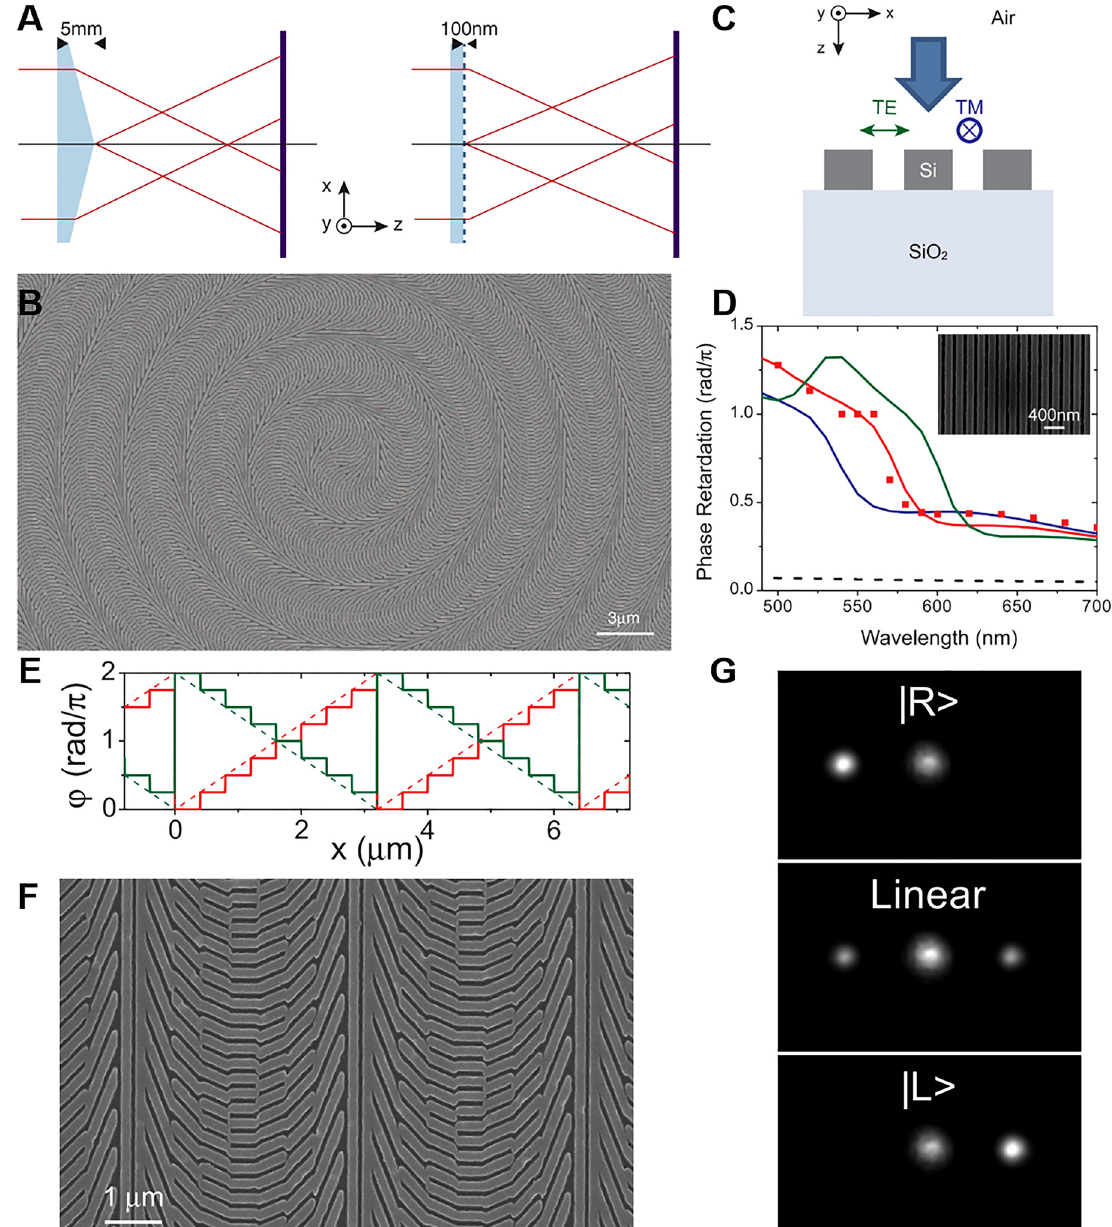
Figure 1: Three dielectric gradient metasurface optical elements (DGMOE) for the manipulation of light [49]. (A)SchematicofaconventionalglassaxicongeneratingaBesselbeam(left)andaDGMOEaxiconfeaturinganultrathinpatternedlayerofsilicon on a quartz substrate (right). (B) Scanning electron microscopy (SEM) image of the fabricatedDGMOE axicon constructedfrom Si nanoantennas. (C) Schematic view of a periodic 120-nm-wide and 100-nm-high Si nanobeam array on fabricated ultrathin wave plates. (D) Simulated phase retardation of a TM-polarized wave with respect to a TE-polarized wave for nanobeam arrays with widths of 100 nm (blue), 120 nm (red), 140 nm (green),withthesamethicknessof100nmanddutycycleof60%.Measurementsofthephaseretardation(redsquares)obtainedwithanarrayof 120-nmwidths(SEMimageininset) showgoodagreementwiththesimulations.Thephaseretardationofthewaveplatevariesfrom0 . 4 π to1 . 2 π with the wavelength from 490 to 700 nm. In contrast, the phase retardation is approximately equal to 0 . 05 π for a 100-nm-thick calcite fi lm (dashedblackline).(E)Discretized(solidline)andcontinuous(dashedline)phasepro fi leofaDGMOEgratingforilluminationwithLCPlight(red) and RCP light (green). (F) SEM image of the fabricated grating. (G) Measured diffraction patterns from the grating under illumination with right circular polarization (top), linear polarization (middle), and left circular polarization (bottom) at λ = 550